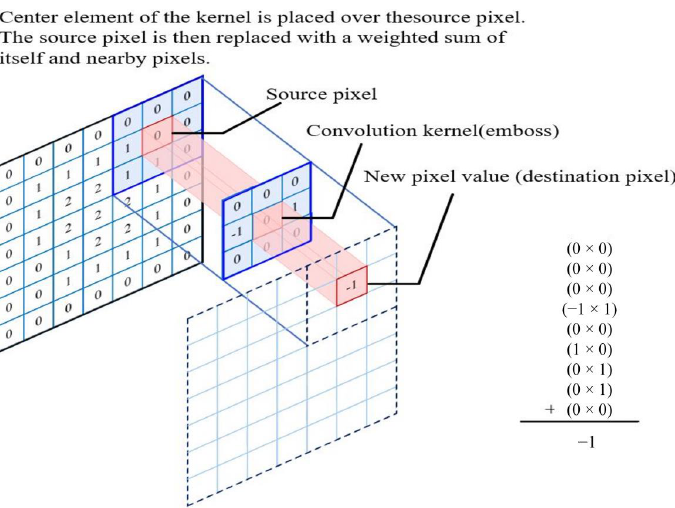
Figure 3. Convolution operation corresponding to the pixel value matrix of the silicon dioxide